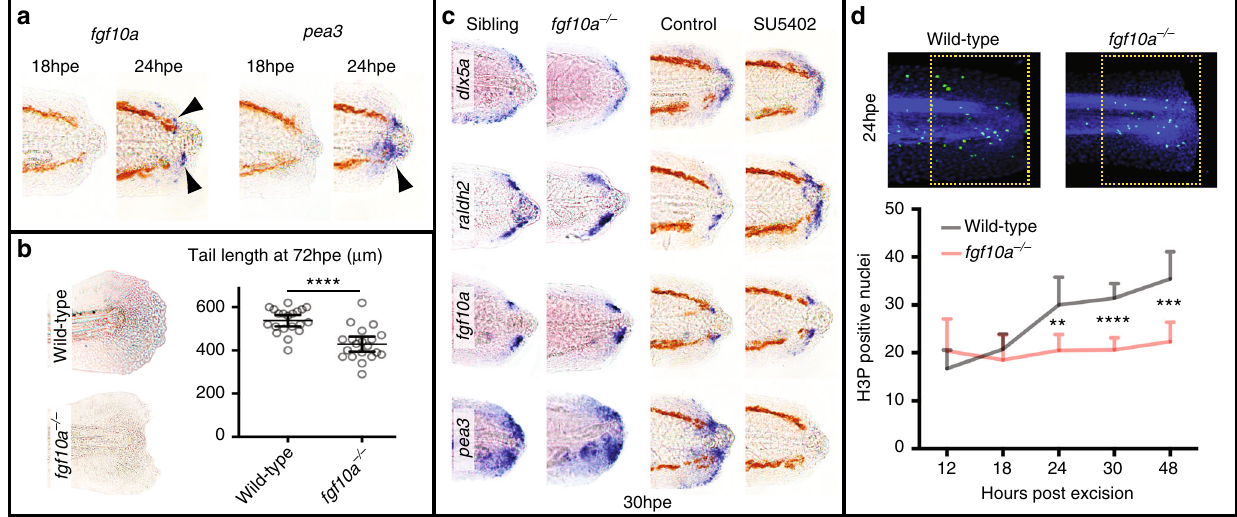
Fig. 1 FGF signalling is required for cell proliferation during larval tail regeneration. a Arrowheads point to expression of the FGF ligand, fgf10a , and the downstream target, pea3 , become evident by 24 hpe (10/10 for both, number of experiments = 3). b fgf10a − / − fi sh have reduced tail regrowth compared to wild-type fi sh. Larvae were imaged at 72 hpe. Tail length was determined using the Measure macro in ImageJ software by placing a rectangle parallel to the body that started at the anus and fi nished at the caudal end of the fi n fold. Unpaired t test two-tailed results in P < 0.0001 indicated as **** (sibling n = 20, fgf10a − / − n = 20, number of experiments = 3). c Expression of dlx5a and raldh2 are not strongly affected when FGF signalling is reduced. SU5402 treatment was done from 26 to 30 hpe at 10 μ M concentration. This treatment is suf fi cient to abolish detection of the FGF downstream target pea3 (10/10 for each panel, number of experiments = 2). d Whereas in wild-type fi sh DNA mitosis increases after tail excision, in fgf10a − / − fi sh mitosis remains constant (wild type/12 hpe n = 8, wild type/18 hpe n = 8, wild type/24 hpe n = 19, wild type/30 hpe n = 21, wild type/48 hpe n = 14, fgf10a − / − /12 hpe n = 8, fgf10a − / − /18 hpe n = 8, fgf10a − / − /24 hpe n = 12, fgf10a − / − /30 hpe n = 20, fgf10a − / − /48 hpe n = 12, number of experiments = 2). Statistics performed with ordinary one-way ANOVA (nonparametric) with multiple comparisons and Sidak hypothesis testing. **** P < 0.0001, *** P = 0.0001 and ** P =